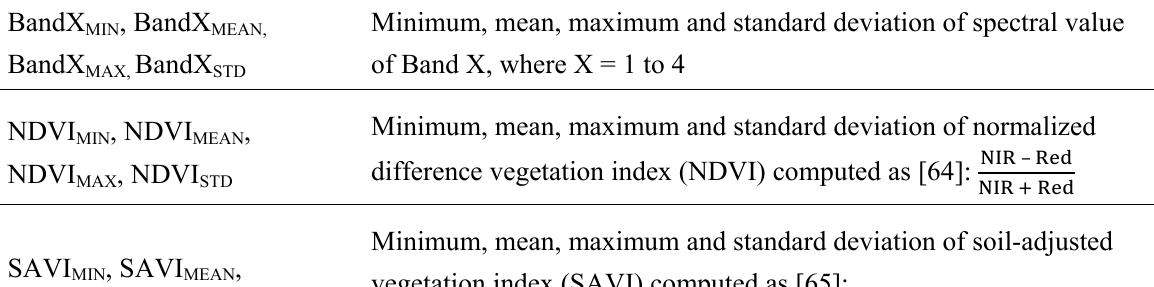
Table 4. Predictor variables computed from Quickbird imagery 1